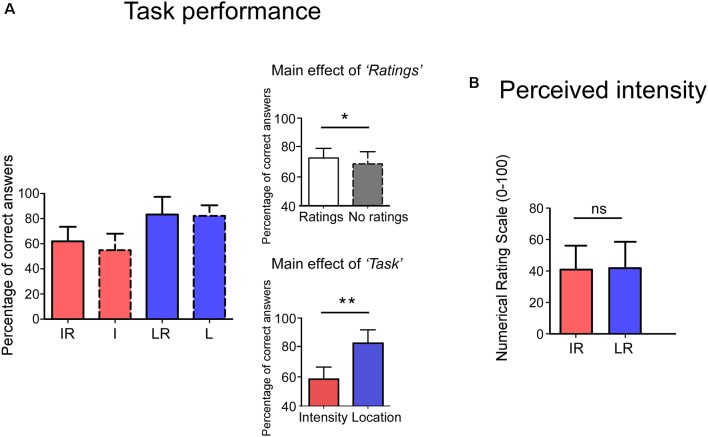
Panel (A), the y-axis shows the percentage of correct answers. Accuracy was higher in the Rating conditions (Main effect of Rating) and in the Location Task (Main effect of Task). Interactions were not significant. Panel (B), no differences were observed in the perceived intensity for the two tasks. The y-axis represents the perceived intensity on a Numerical Rating Scale (NRS) ranging from 0 to 100. IR = Intensity + Ratings, I = Intensity LR = Location + Ratings, L = Location. *p < 0.05, **p < 0.001, ns, not significant.